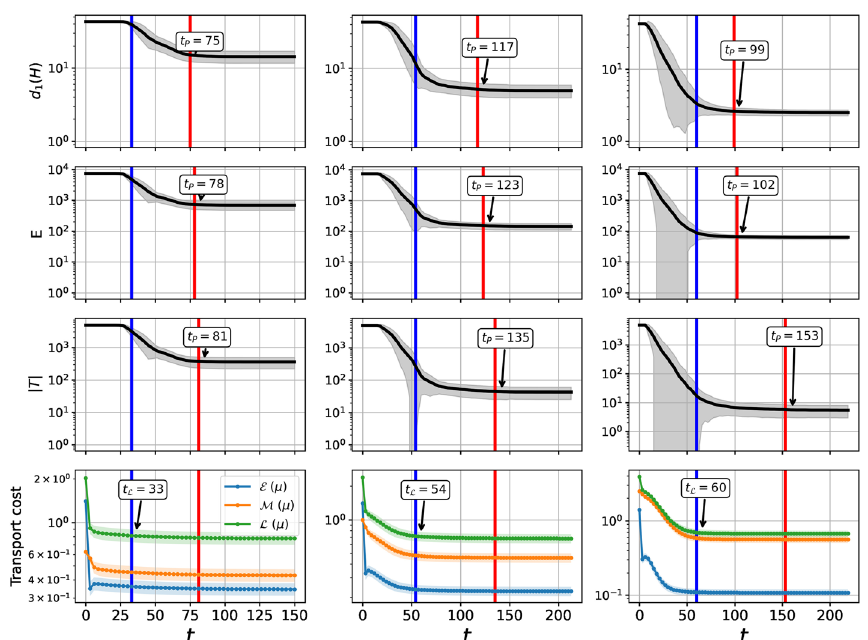
Fig. 9 Other hypernetwork properties and Lyapunov cost. From left to right: β = 1.2,1.5 and 1.8. From top to bottom: Mean and standard deviation of the average degree d 1 ( H ) , number of hyperedges | E H | , number of triangles | T |, and the Lyapunov cost L , energy dissipation E and structural cost M . Red and blue lines denote t P and t L for p =